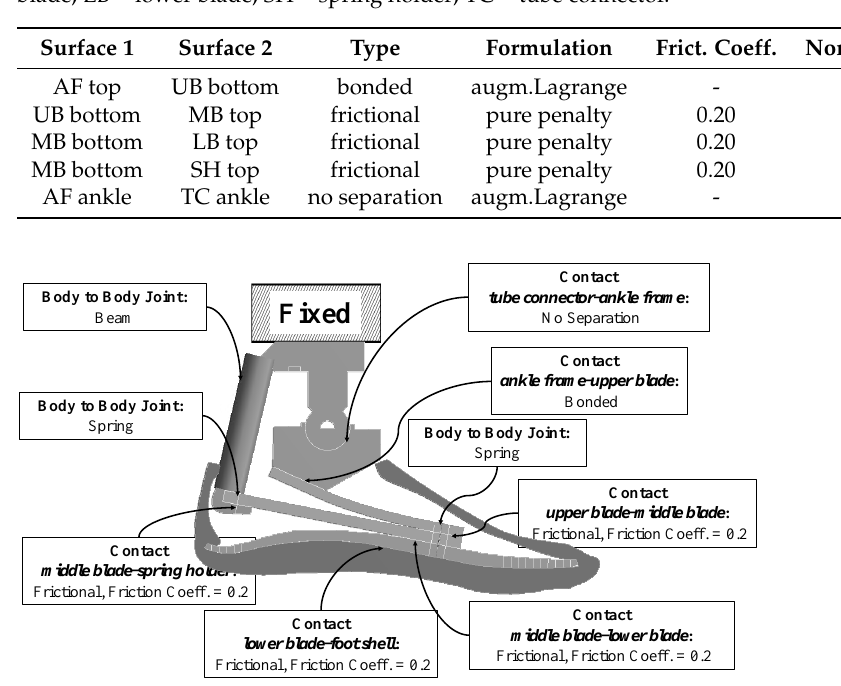
Figure 7. Joint and contact modeling in the 2D FE model. See also Table 4 for detailed